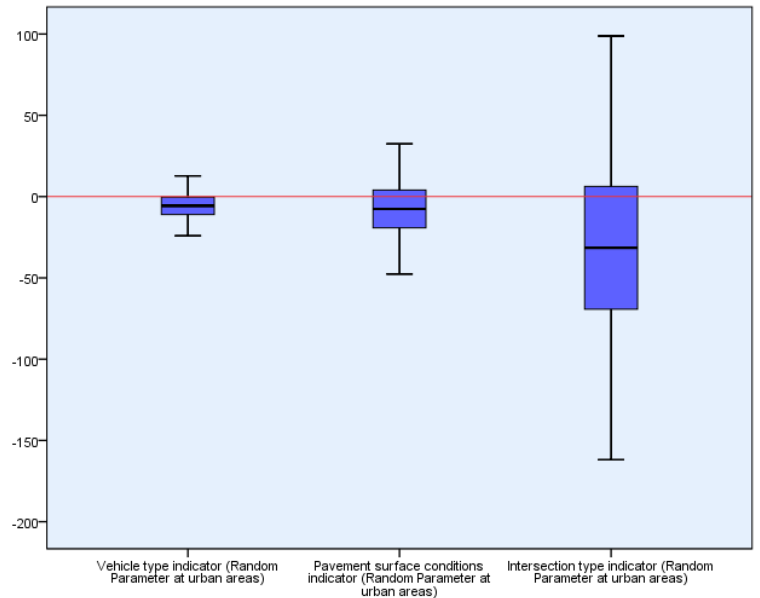
Figure 2. Boxplots illustrating the random parameters’ distributions in the accident injury severity model for urban areas (the lower and upper limits of the box reflect the interquartile range, the thick line in the middle of the box represents the median, the red line indicates the zero value, and the whiskers are defined by the minimum and maximum values of the distribution).